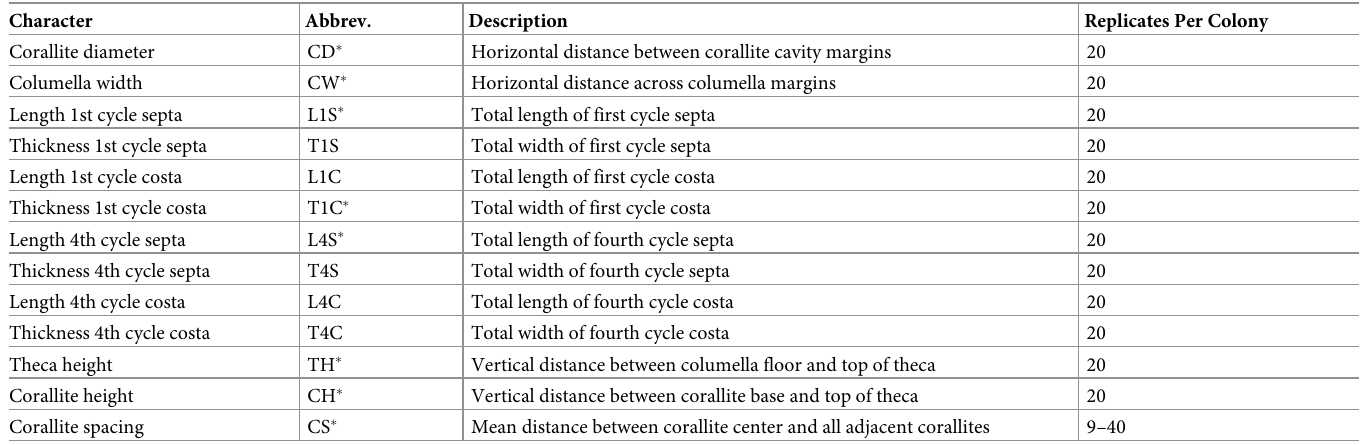
Table 1. Corallite morphological